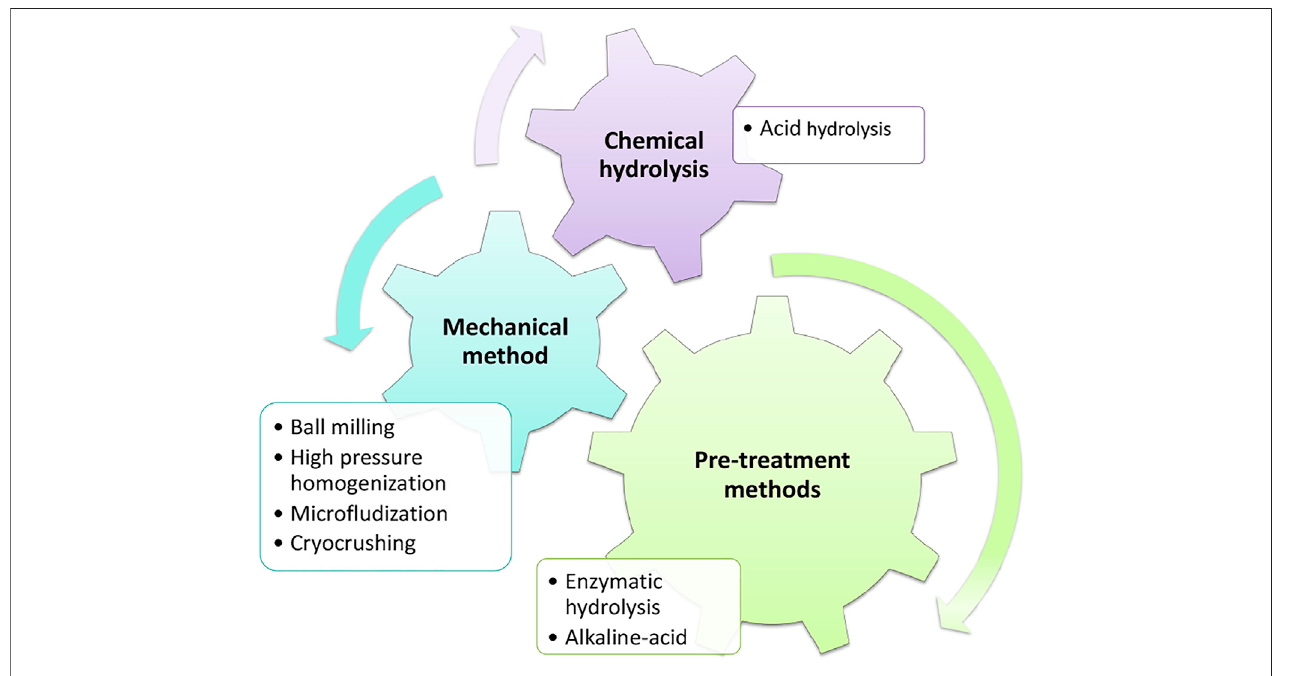
FIGURE 4 | Schematic representation of micro fl udizer.